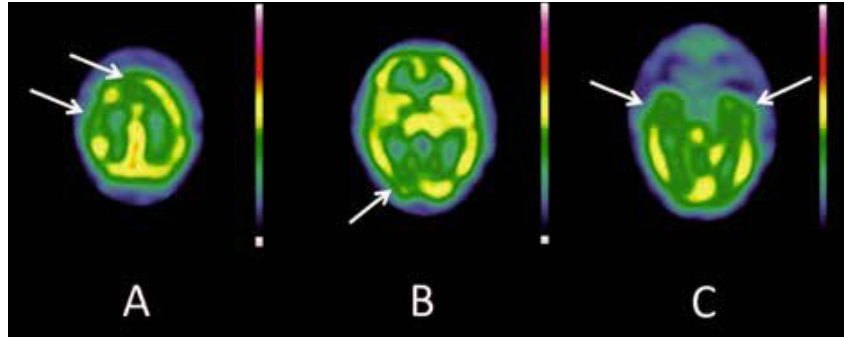
Fig. 1. SPECT brain Tc99m (March 2013): A = reduced right frontal and paracingular cortex; B =